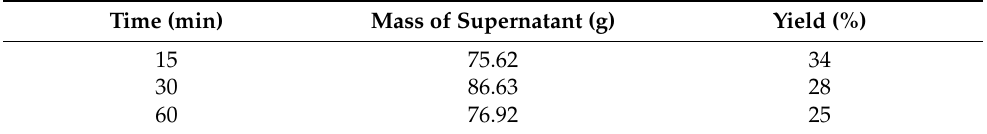
Table 3. Impact of the reaction time on the conversion yield. Reaction conditions: 10 g of a selected rapeseed cake; 100 mL of formic acid with 4–5 drops of H 2 SO 4 ; stirred at 60 ◦ C for a defined period. Time (min) Mass of Supernatant (g) Yield (%) 15 75.62 34 30 86.63 28 60 76.92 25